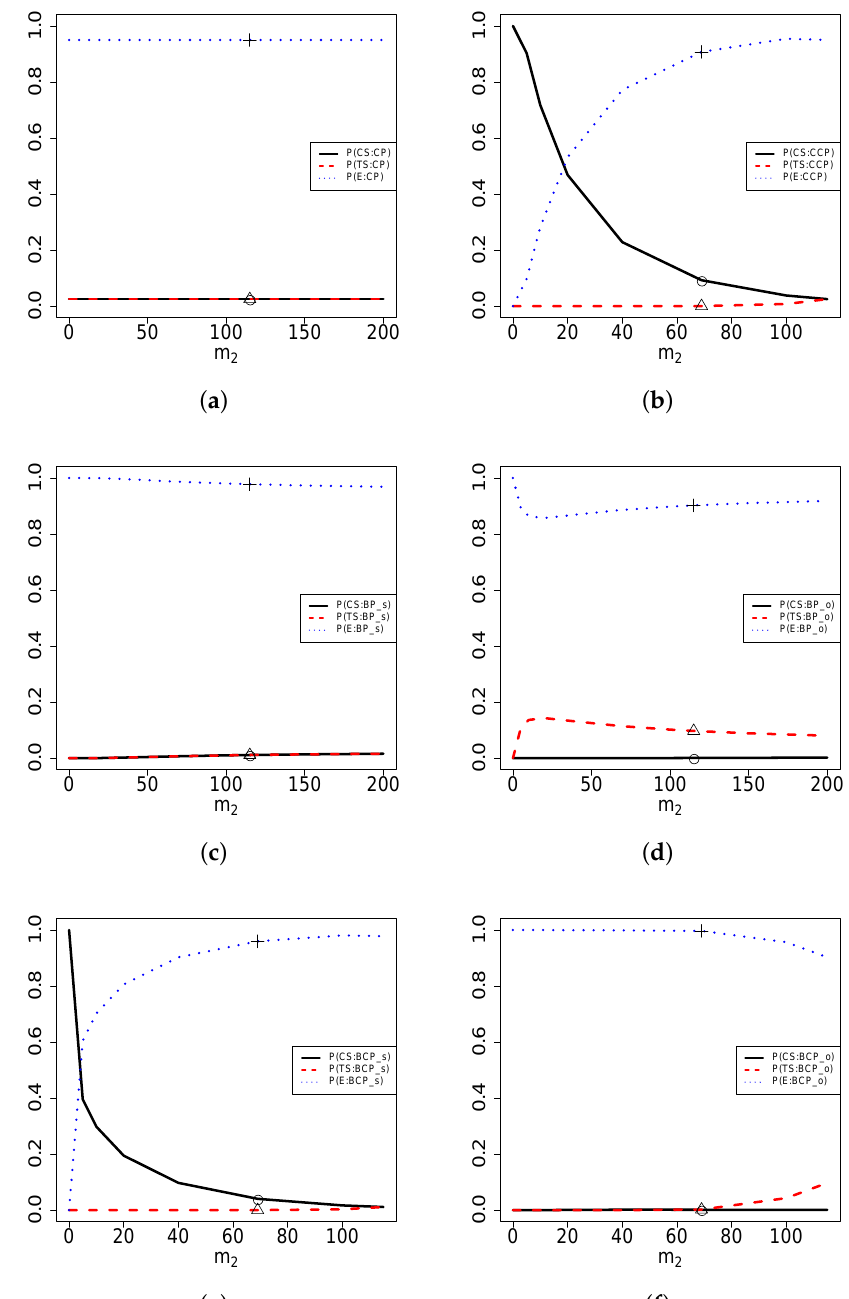
Figure 5. The probabilities of CS, TS, and E for CP, CCP, BP, and BCP as functions of m 2 when δ = 0, which favors equivocal. ( a ) CP; ( b ) CCP; ( c ) BPs; ( d ) BPo; ( e ) BCPs; ( f )